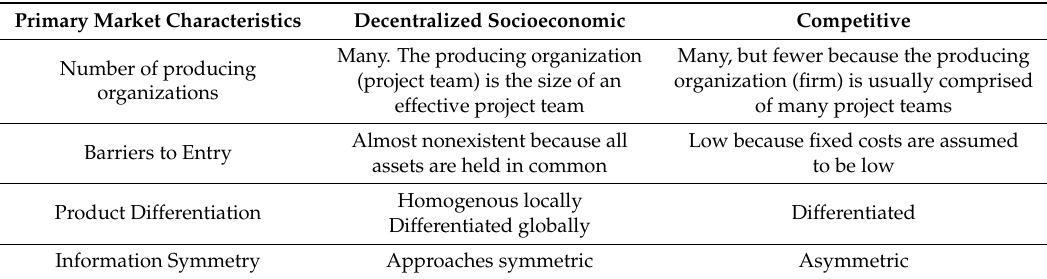
Table 2. Comparison of the primary market characteristics of competitive and decentralized socioeconomic markets. They are similar except for information symmetry, the result of using Blockchain, and product differentiation, the result of collaborative vs competitive incentive models within the